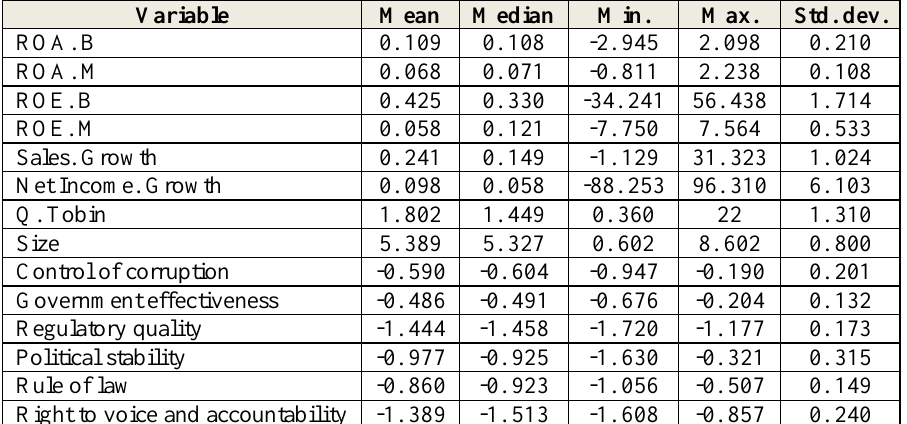
Table 2 . General descriptive statistics of research variables